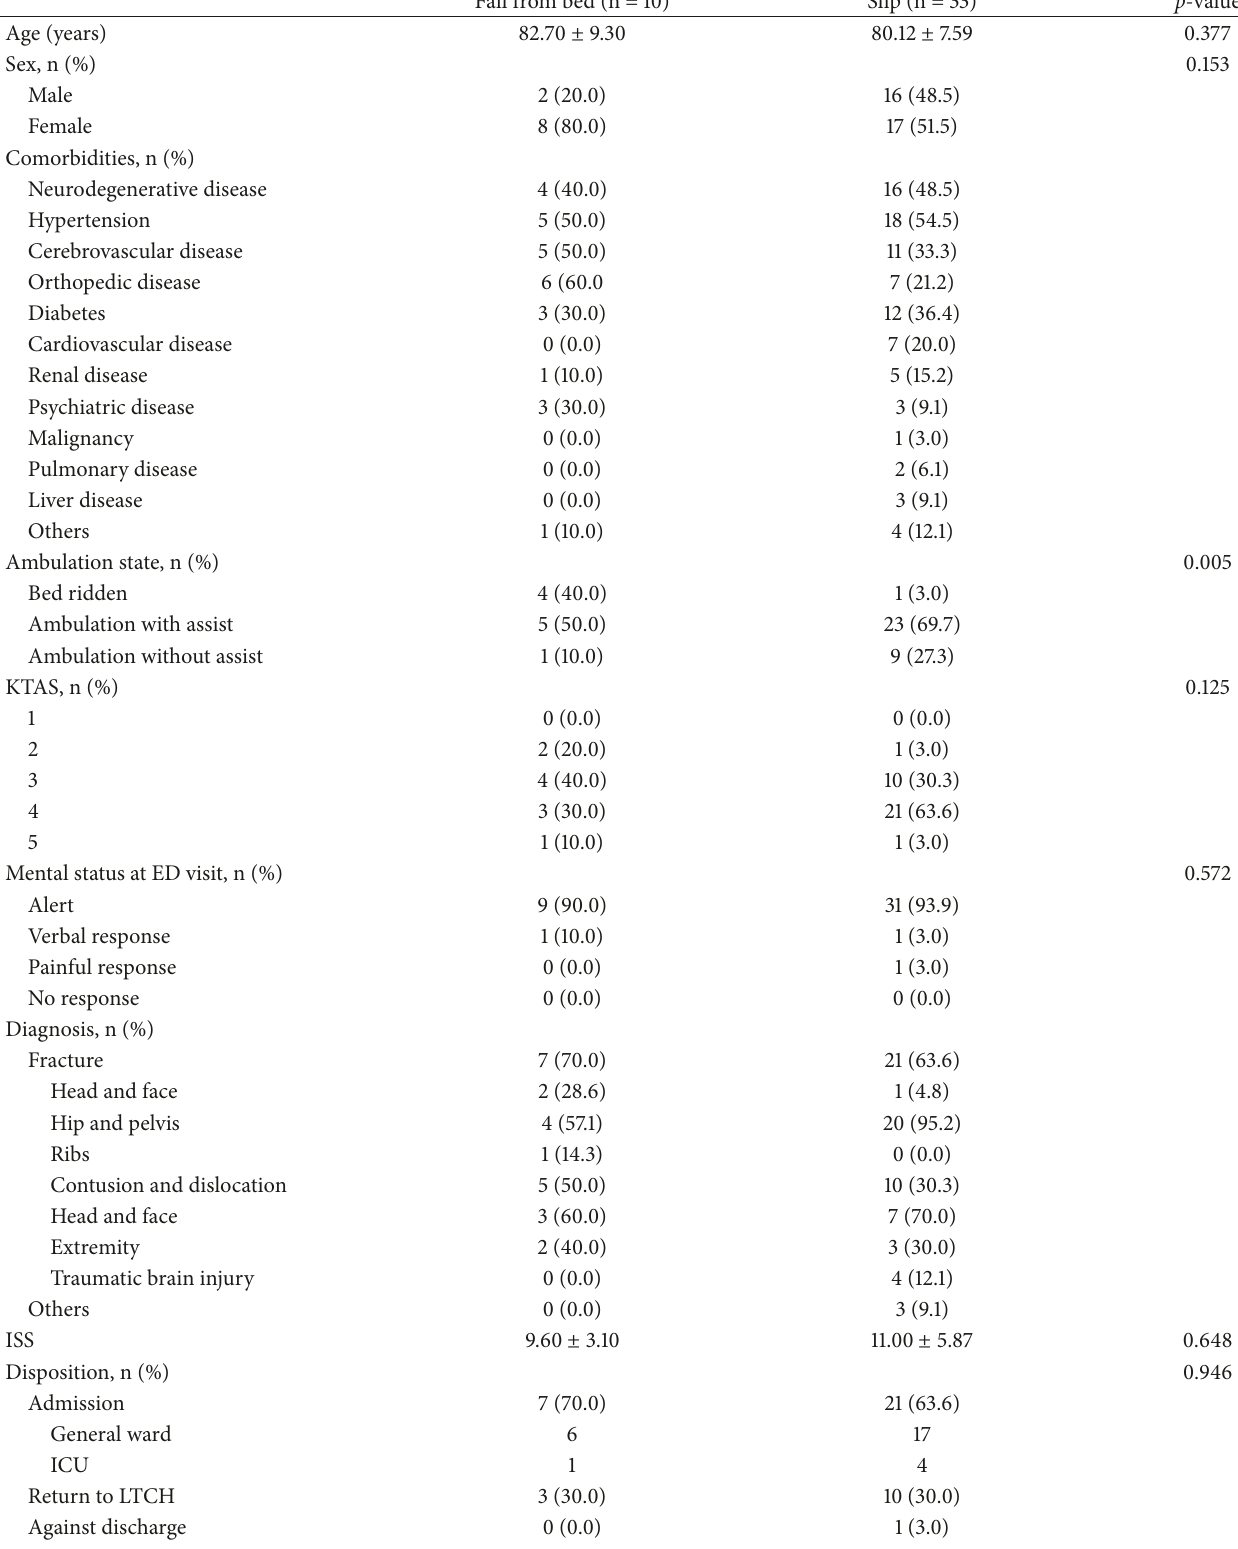
Table 4: Comparison of injury mechanism between slip and fall from a bed from long-term care hospital. Fall from bed (n =